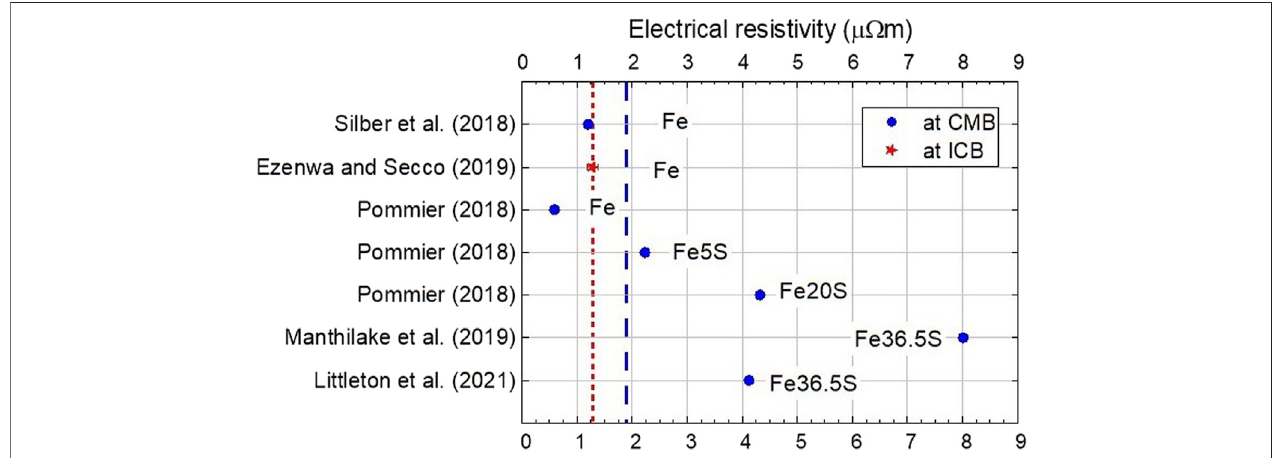
FIGURE6| Combinedvaluesof ρ fromtheliteratureappliedtoGanymede ’ scorepresentedindateorder.Thebluedashedlinerepresentstheaveragevaluesatthe CMB,whilethereddashed linerepresentstheaverageattheICB.TheaverageofallreportedvaluesatCMB(1,400 – 2000K,5 – 7 GPa)conditionsis1.90 µ Ω m,andthat at the ICB (2,200 K, 9 GPa) is 1.28 µ Ω m. Repeated references indicate different